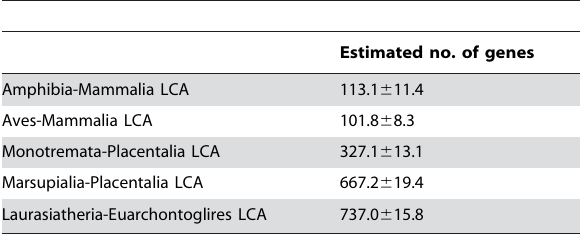
Table 3. Number of OR genes in LCA estimated using Eq. 9 and based on the bootstrap analysis.